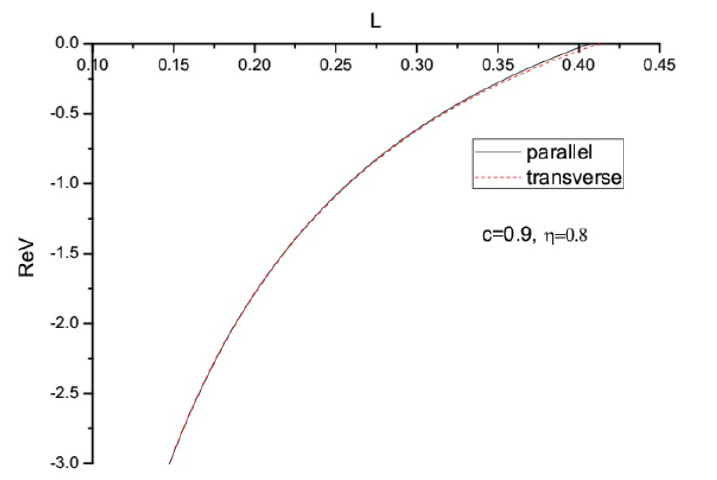
Figure 3 . Re V as a function of L , for fixed value of η and fixed value of c , T = 200 MeV , as a Q ¯ Q comparison between the parallel and the transverse cases. The solid black line shows parallel case and the dashed red line shows transverse